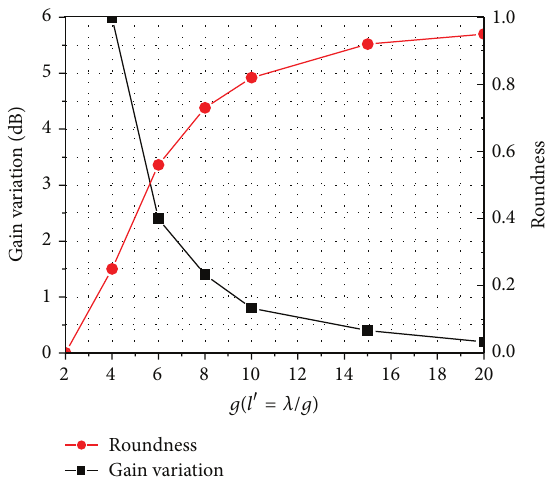
Figure 3: Roundness and gain variation against 𝑙 󸀠 .